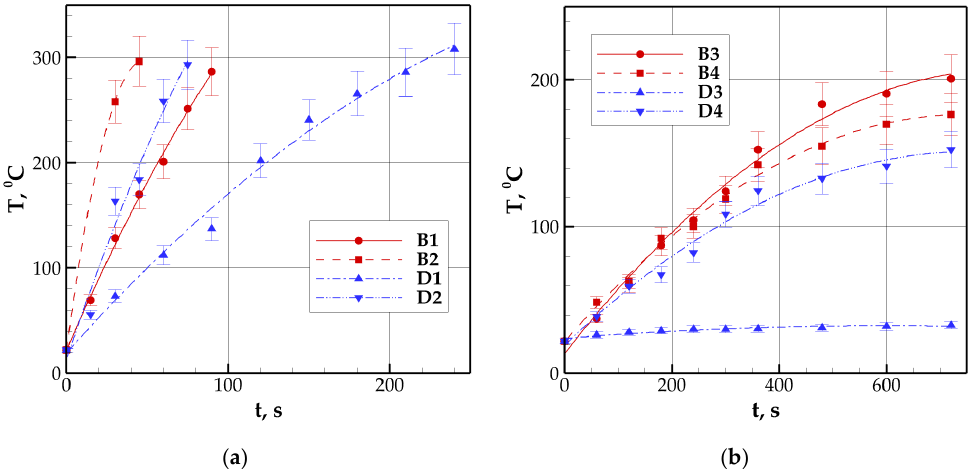
Figure 4. Heating dynamics of source rock samples B1–B4 and D1–D4 under the influence of ( a ) microwave electromag- netic field; ( b ) radio-frequency electromagnetic field. ( a ) microwave electromagnetic field; ( b ) radio-frequency electromagnetic